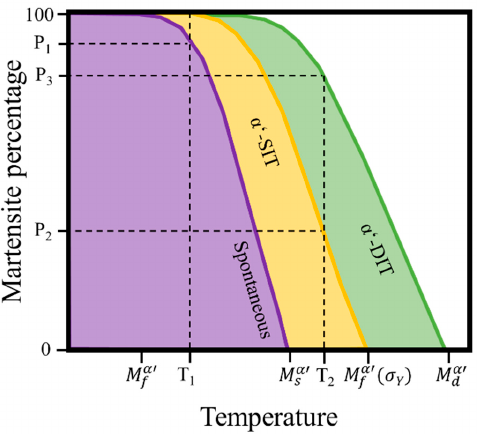
Figure 3. Schematic diagram showing the temperature dependence of stress/strain-induced and spontaneous martensite fractions. Abbreviations are described in Section 2. Adapted from [95]. Units are arbitrary.